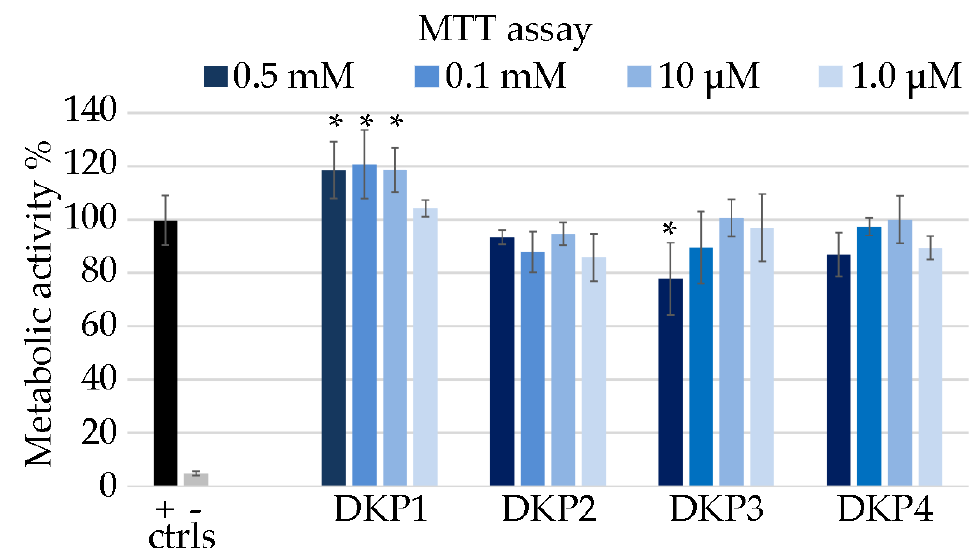
Figure 7. MTT assay on fibroblast cells treated with the DKPs 1–4, or 1% SDS ( − ctrl), or untreated (+ ctrl). Metabolic activity % is shown relative to the + ctrl. * denotes p < 0.01.